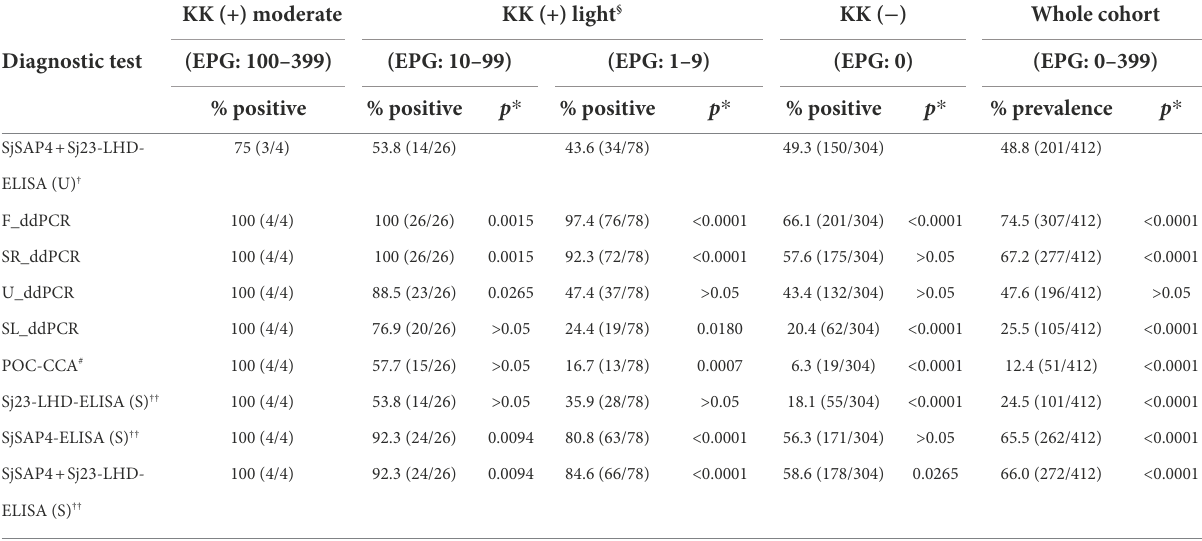
TABLE 1 Comparison of positivity rates in different subgroups and prevalence in the whole cohort determined by the urine ELISA assay with those obtained with other diagnostic tests.